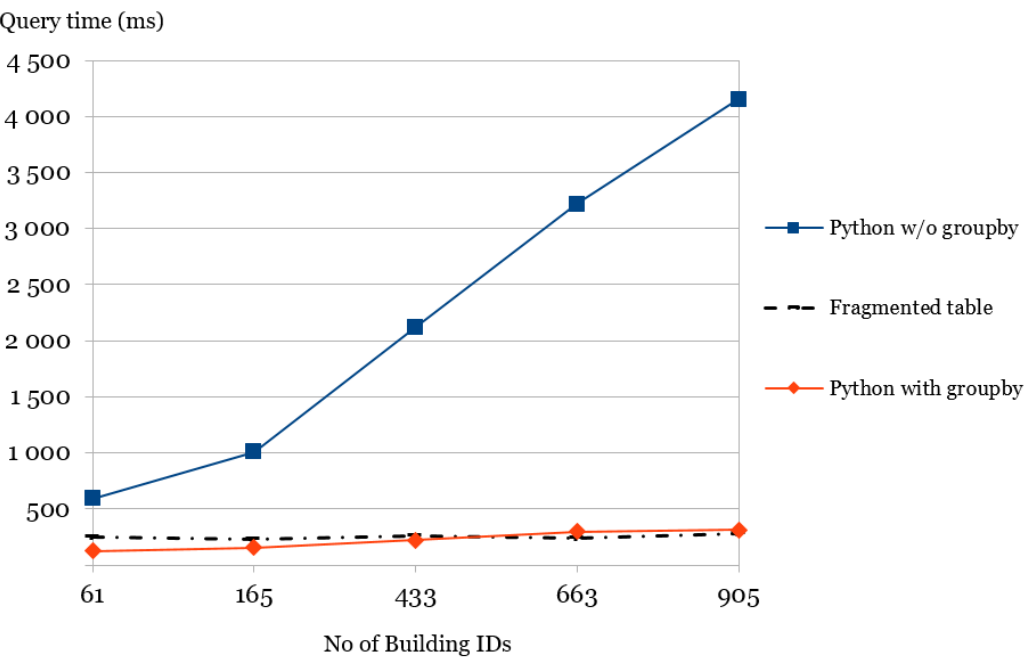
Figure 5. A graph representing the time in milliseconds for the five different types of more complex queries using the extended small dataset as defined in Table 8. Note how the performance of the Python-without-groupby queries rapidly deteriorate due to the need to process an increasing number of Points files, with one Points file being read and processed for each separate building